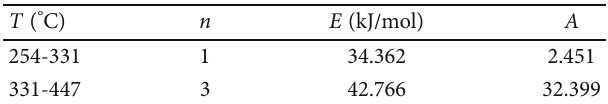
Figure 9: Dry distillated pine tar combustion reaction rate correlation. Table 3: The dry distillated pine tar kinetic parameters at the no. 1